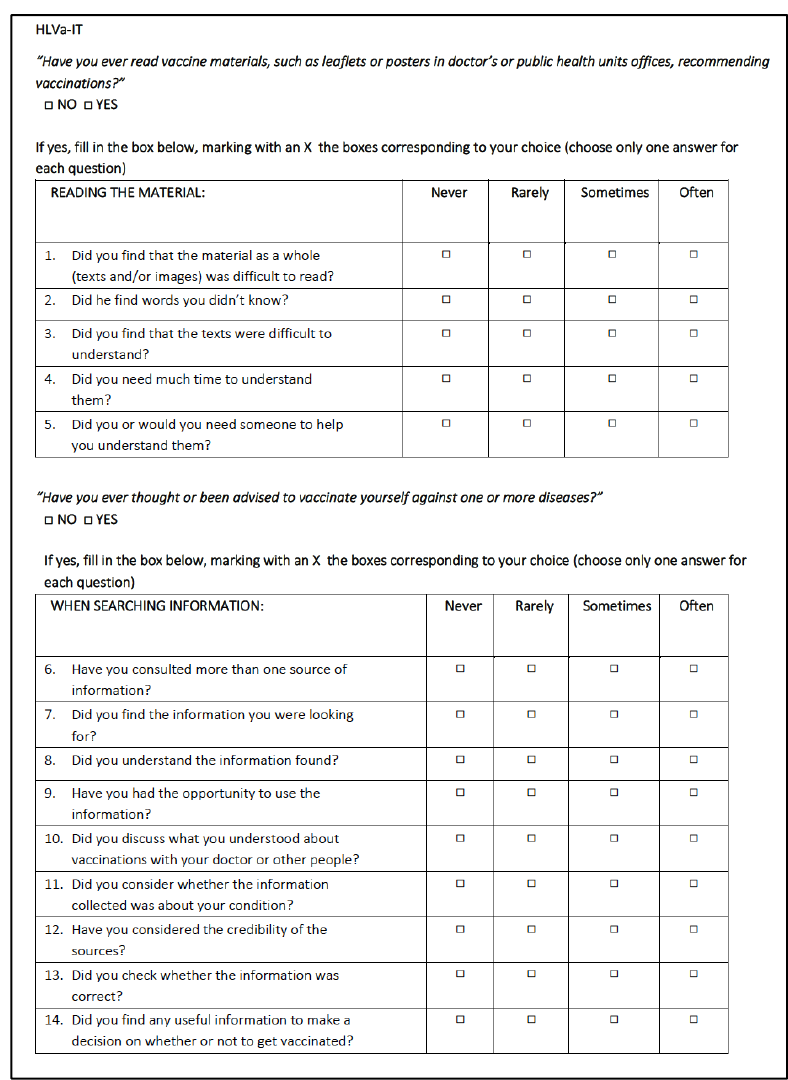
Figure 1. The HLVa ‐ IT included in the study . Figure 1. The HLVa-IT included in the